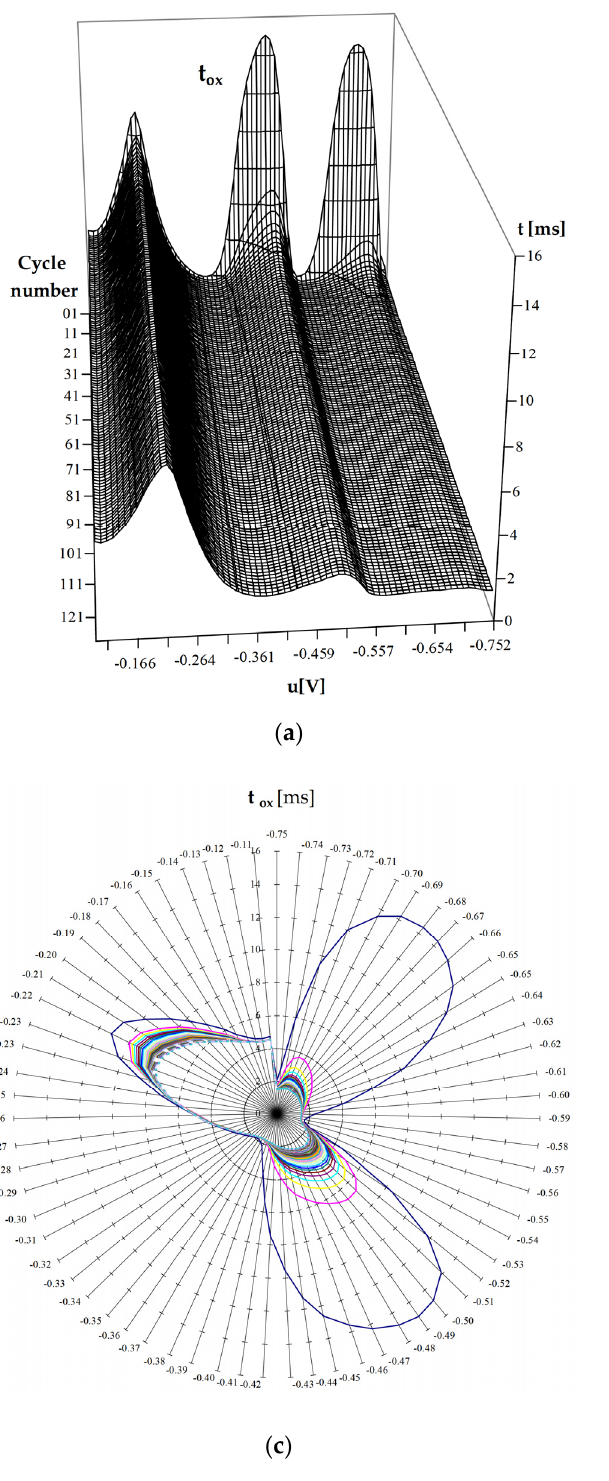
Figure 4. Initial analytical signal of analyzer “ASC-2000”. Matrices of time intervals ( a , c )—anodic prosses, ( b , d )—cathodic prosses . prosses, ( b , d )—cathodic